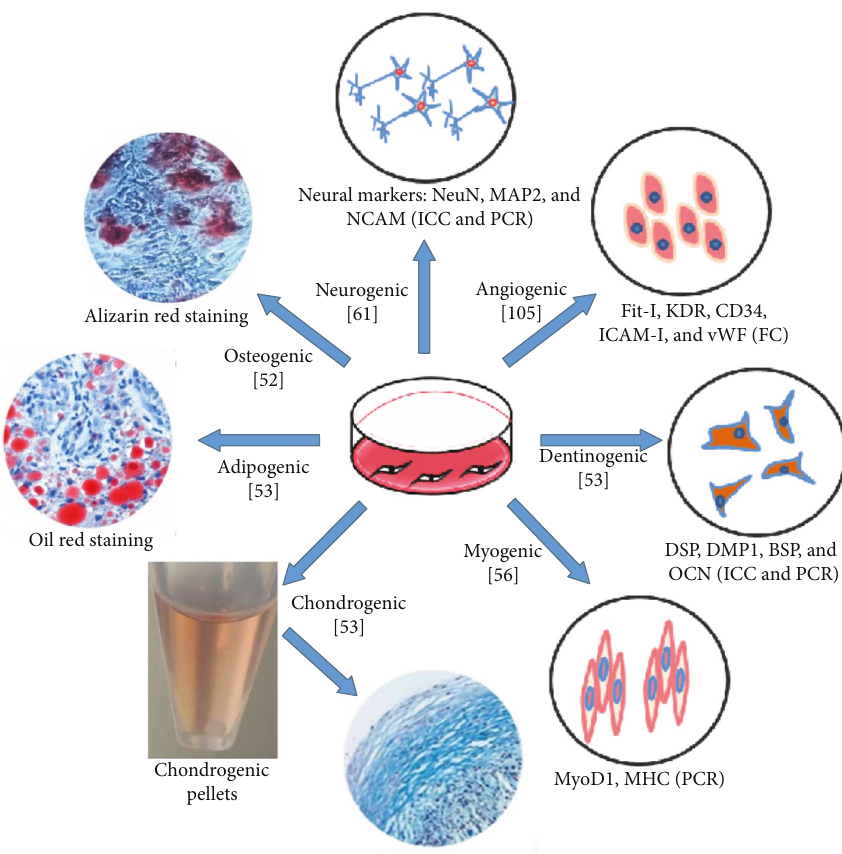
Figure 1: Multidi ff erentiation potential of DPSCs. DPSCs possess MSC-like properties and are multipotent. NCAM : neural cell adhesion molecule; MAP2: microtubule-associated protein 2; NeuN: neuron-speci fi c nuclear protein; Fit-I: VEGF receptor 1; KDR: VEGF receptor 2; CD34: cluster of di ff erentiation 34; ICAM-I: intercellular cell adhesion molecule-1; vWF: von Willebrand factor, DSP: dentin sialoprotein, DMP1: dentin matrix acidic phosphoprotein 1, BSP: bone sialoprotein, OCN: osteocalcin, MyoD1: myoblast determination protein 1; MHC: major histocompatibility complex; PCR: polymerase chain reaction; FC: fl ow cytometry; ICC: